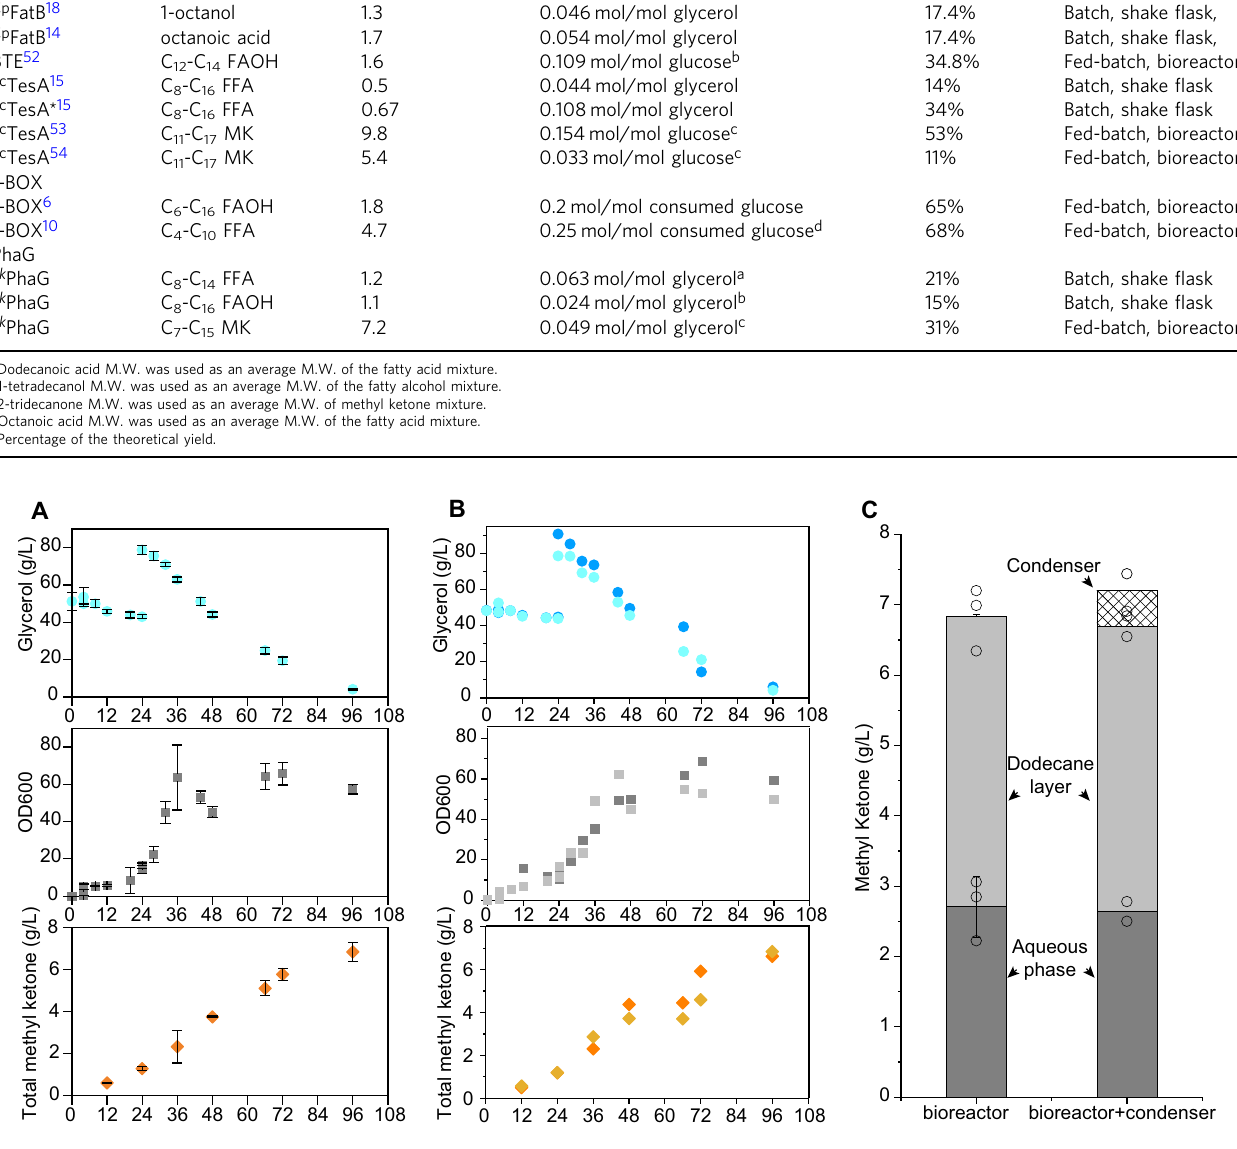
Fig. 6 Fed-batch fermentation for methyl ketone production. Time course of glycerol consumption, OD 600 , and methyl ketone titer from fed-batch bioreactor cultures ( n = 3 biologically independent samples). A and bioreactor coupling a condenser ( n = 2 biologically independent samples) B using E. coli RADI harboring pTRC99a- Pk phaG *- Ps fadM and pACYC- Pa phaJ3 plasmids. C Evaluation of methyl ketone concentration from samples in the aqueous phase (dark gray), dodecane layer (light gray), and condenser (shading) after 96 h fermentation. All data represent the mean ± s.d. of biological triplicates. Source data underlying A – C are provided as a Source Data fi E. coli DH5 α strains were used for plasmid ampli fi cation and DNA assembly. E. coli RABIJ (MG1655 Δ araBAD Δ fadR Δ fadA Δ fadB Δ fadI Δ fadJ ) and E. coli CM23